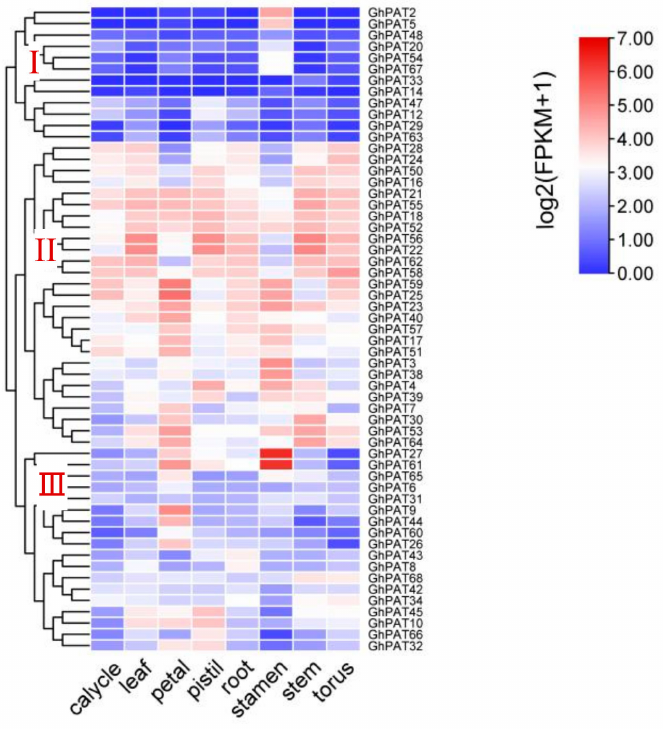
Figure 7. Tissue-specific expression analysis of